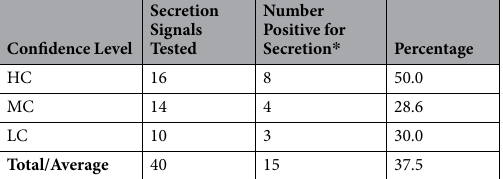
Table 2. Percentage of Populus SSPs that encode secretion signals recognized in S. cerevisiae. A subset from each confidence level of predicted P. trichocarpa SSPs was tested. Confidence levels HC, MC and LC represent three computationally-predicted SSP sets: the high confidence set (“SSP_hc set”), the medium confidence set (“SSP_mc set”) and the low confidence set (“SSP_lc set”), respectively. * See Supplementary Table S6 for detailed